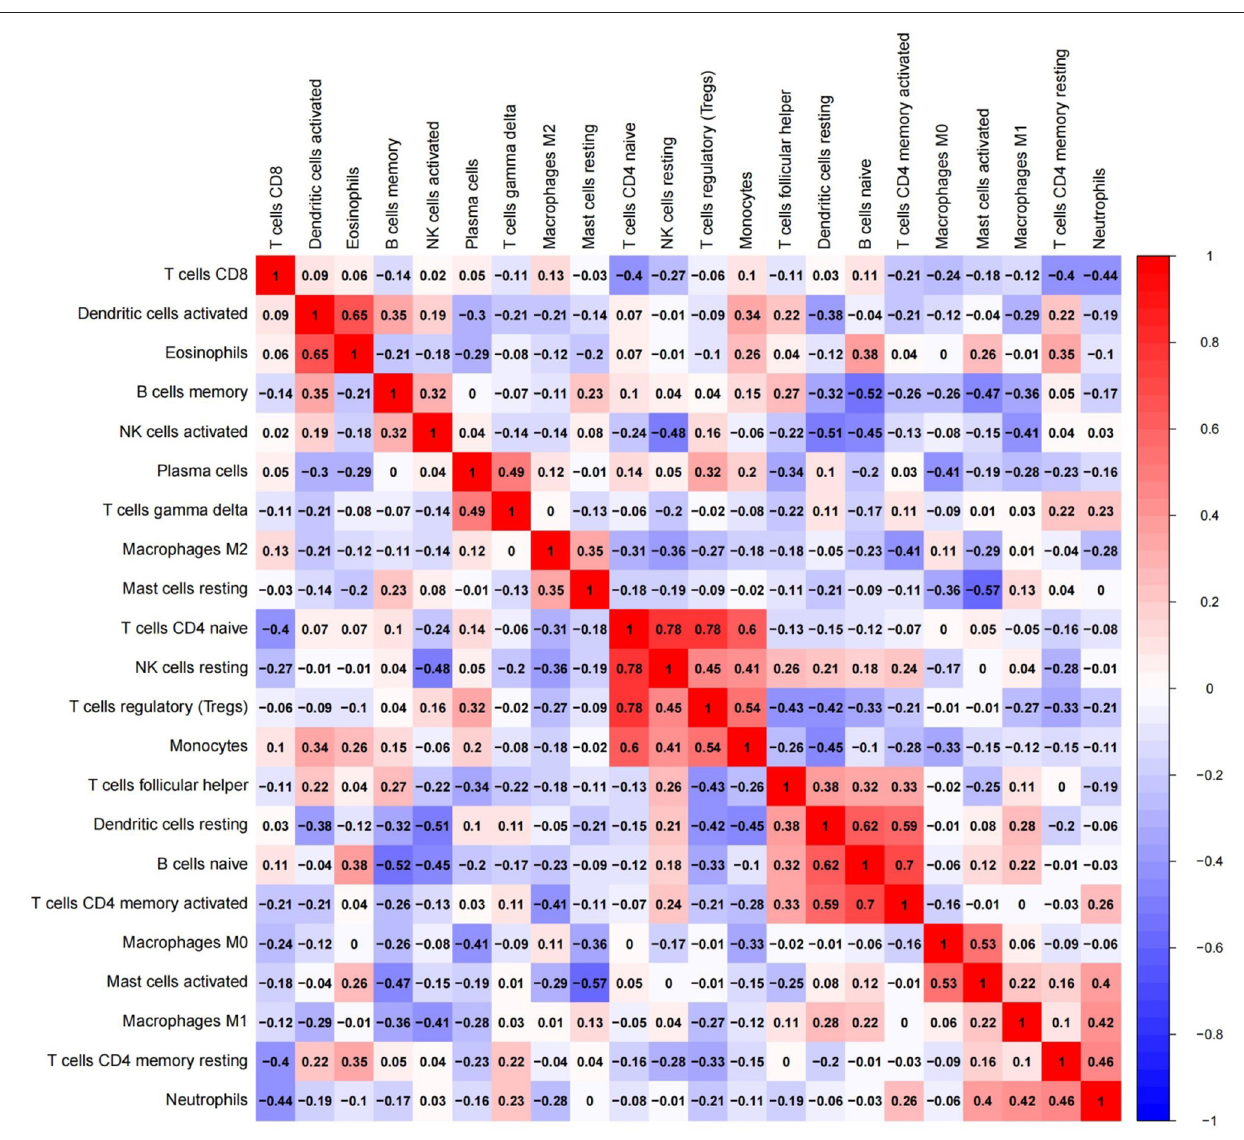
immune cells in tissues are follicular helper T cells, NK cells, M2 macrophages and resting mast cells ( Figure 5 , Table 3 ). Thus, different EMS r-AFS classifications were associated with distinct immune